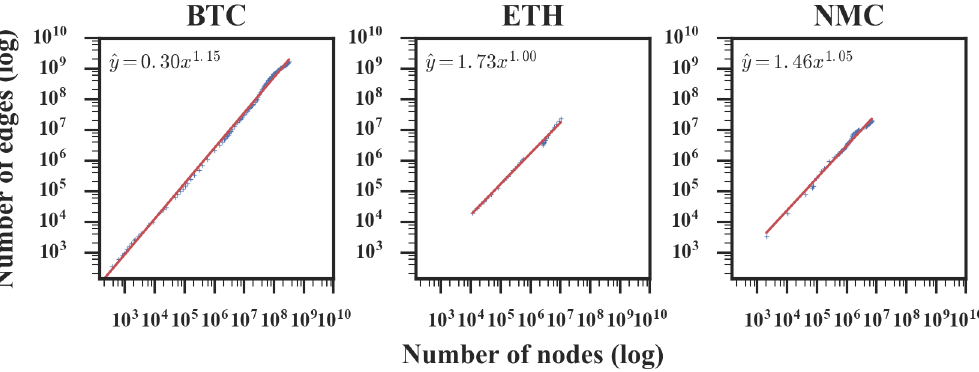
Fig 4. The number of edges e ( t )versus the number of nodes n ( t )in accumulated transaction networks in log coordinate. The red lines show fitted power-law distribution for the networks. In the figure’s equation, x represents the number of nodes and ^ y represents the fitting number of edges, and the exponents are 1.15, 1.00, 1.05,